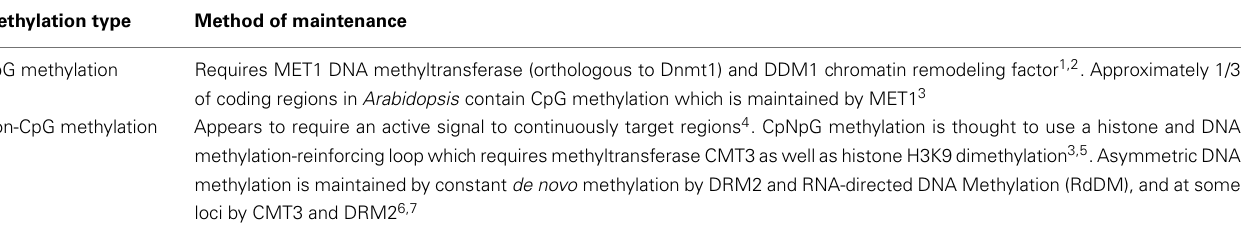
Table 1 | Maintenance methylation in plants.